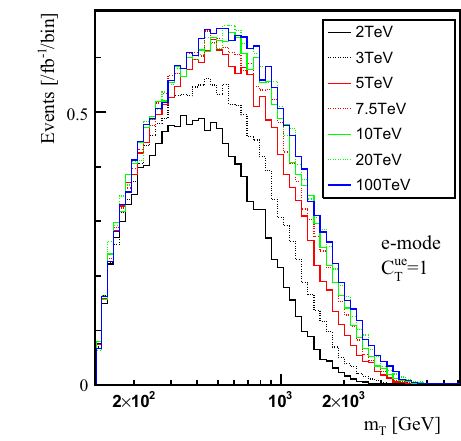
Fig. 2 The simulated m T distributions of pp → e ± + missing for the tensor type NP in the bu → e ν mode with M LQ = 2 , 3 , 5 , 7 . 5 , 10 , 20 (Λ ) = and 100TeV by fixing C ue LHC T